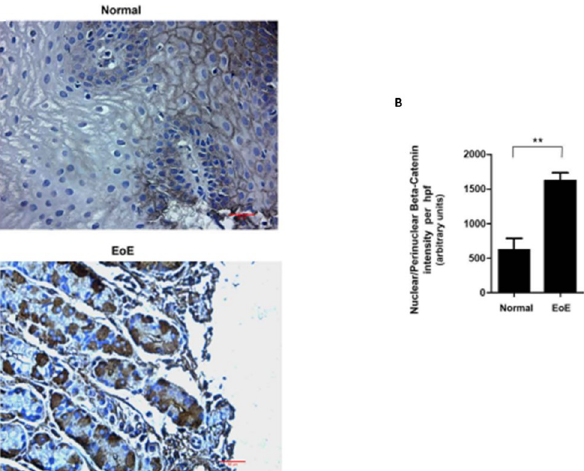
Fig 5. A. IHC analysis of β -catenin in esophageal tissue from pediatric control and EoE patients showing β -catenin localized mainly at nuclear/perinuclear space. B. Densitometric analysis of nuclear/perinuclear β -catenin in EoE and control patient esophageal biopsy tissue. Values are representative of the mean of a sample size of 18 control and 18 patients with EoE. �� P < 0.05.